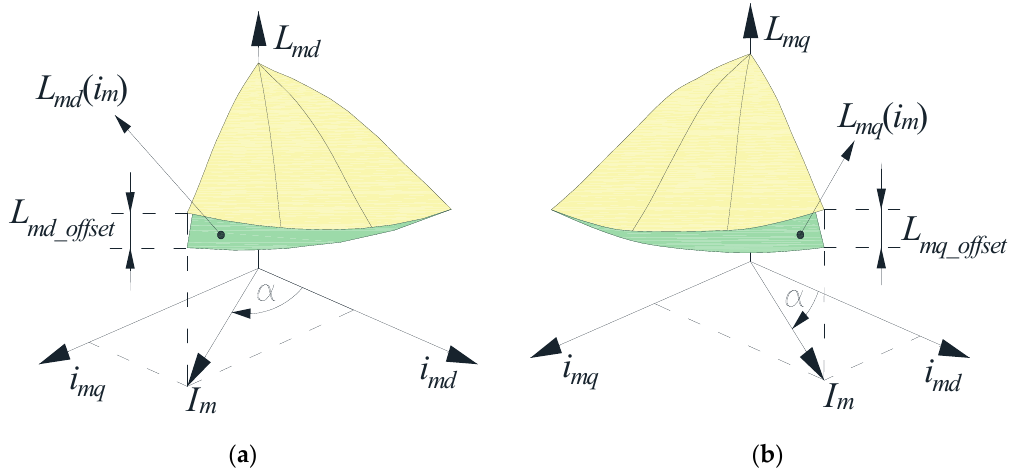
Figure 4. The principle of generating magnetizing inductance surfaces as proposed in [6]: ( a ) d -axis magnetizing inductance surface; ( b ) q -axis magnetizing inductance surface. magnetizing inductance surface; ( b ) q -axis magnetizing inductance surface.